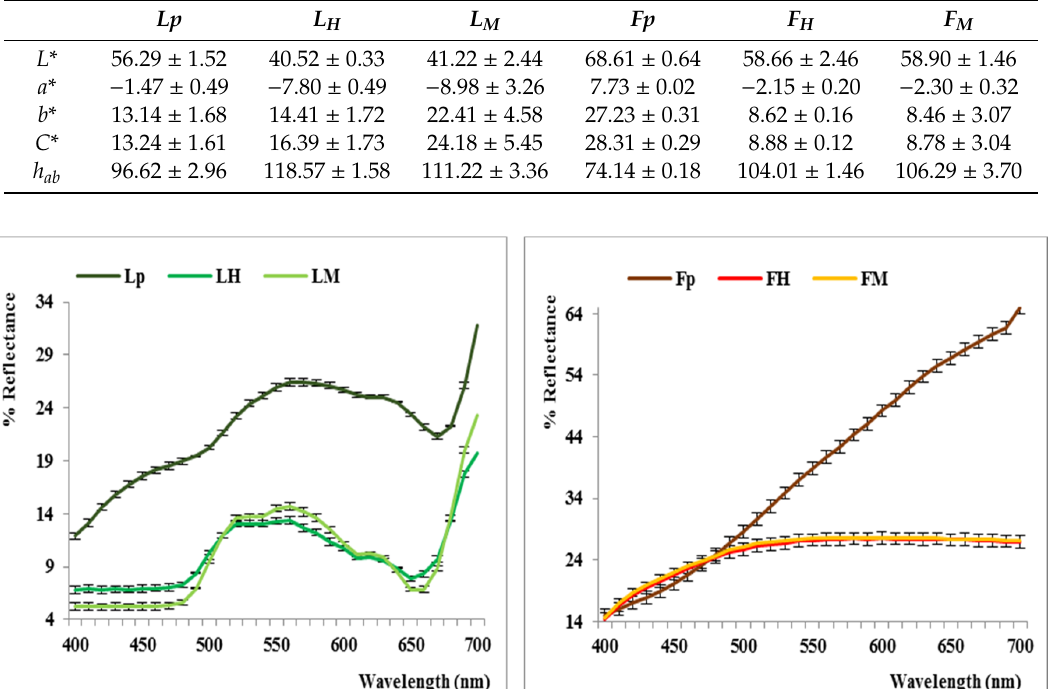
Figure 2. Reflectance curves of E. angustifolia fruits and leaves (powders and extracts).